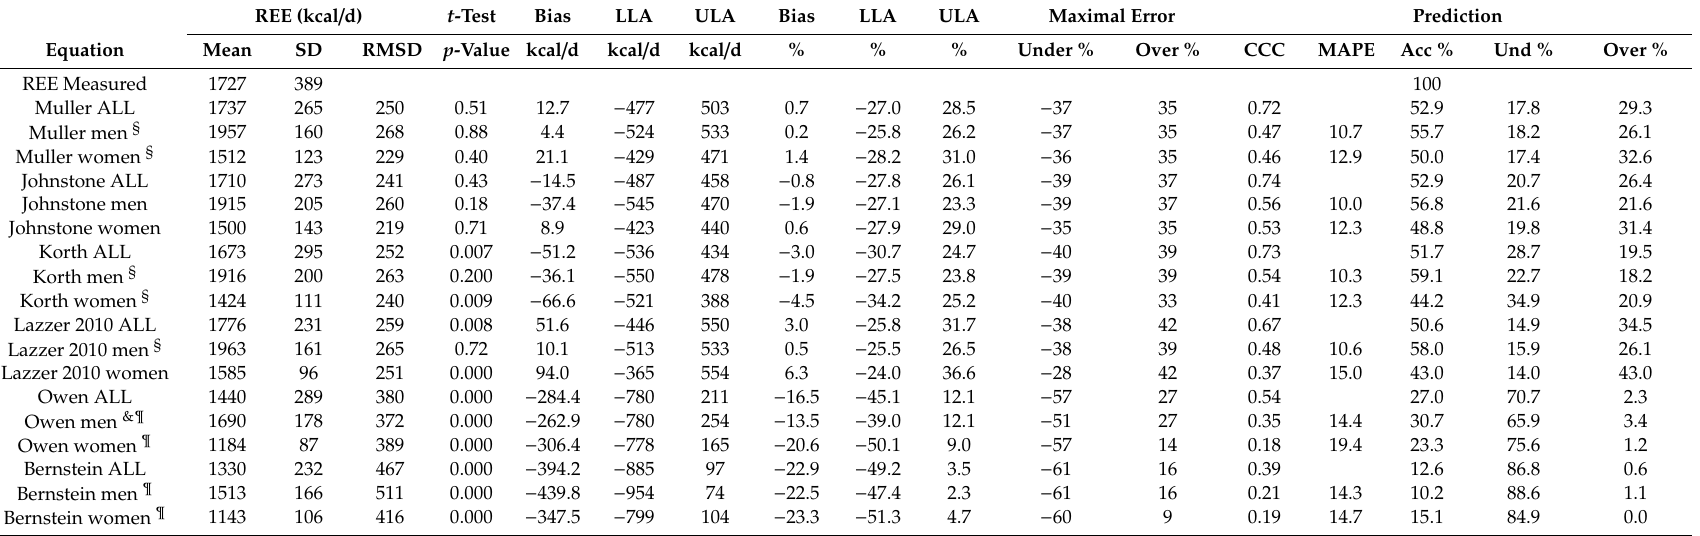
Table 6. Assessment of resting energy prediction equations using body composition data in overweight and obese adults (88 men and 86 women) from the population of